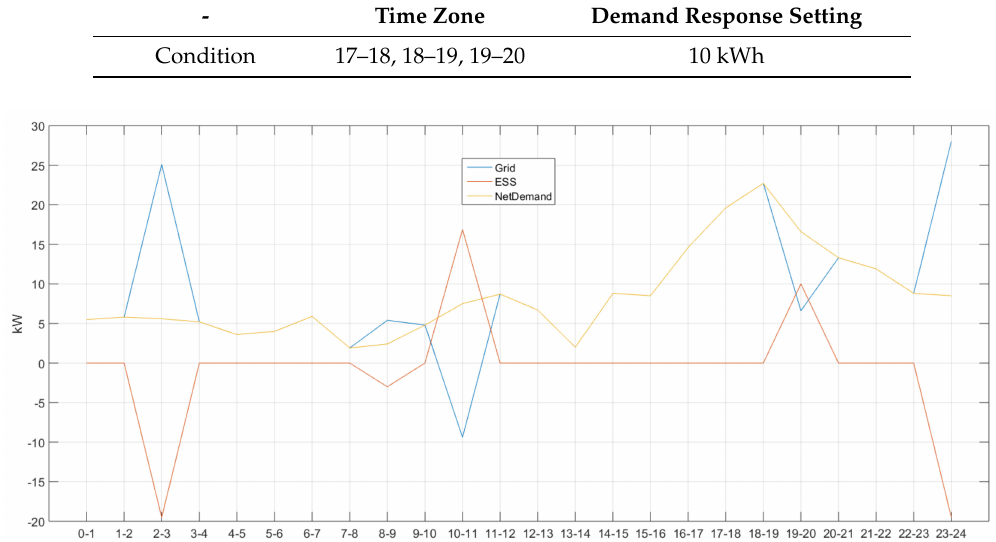
Figure 6. Simulation result when the conditional equation for demand response (power usage) was